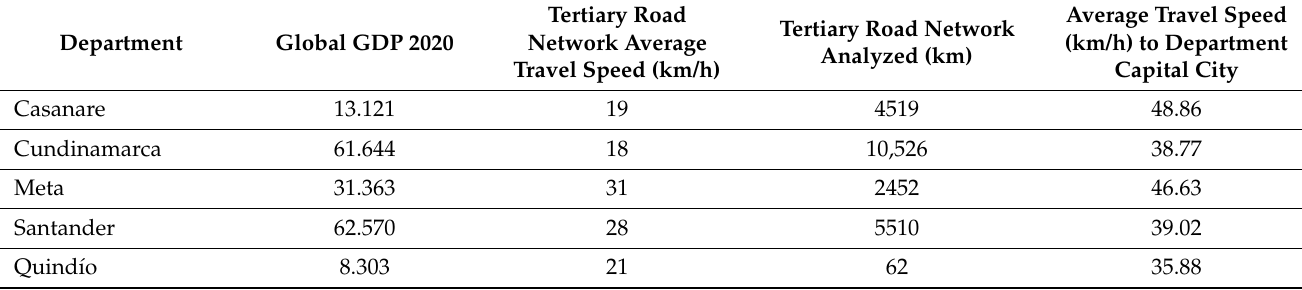
Table A6. Colombia departments were analyzed by adding municipalities’ information. GDP 2020 in thousands of millions